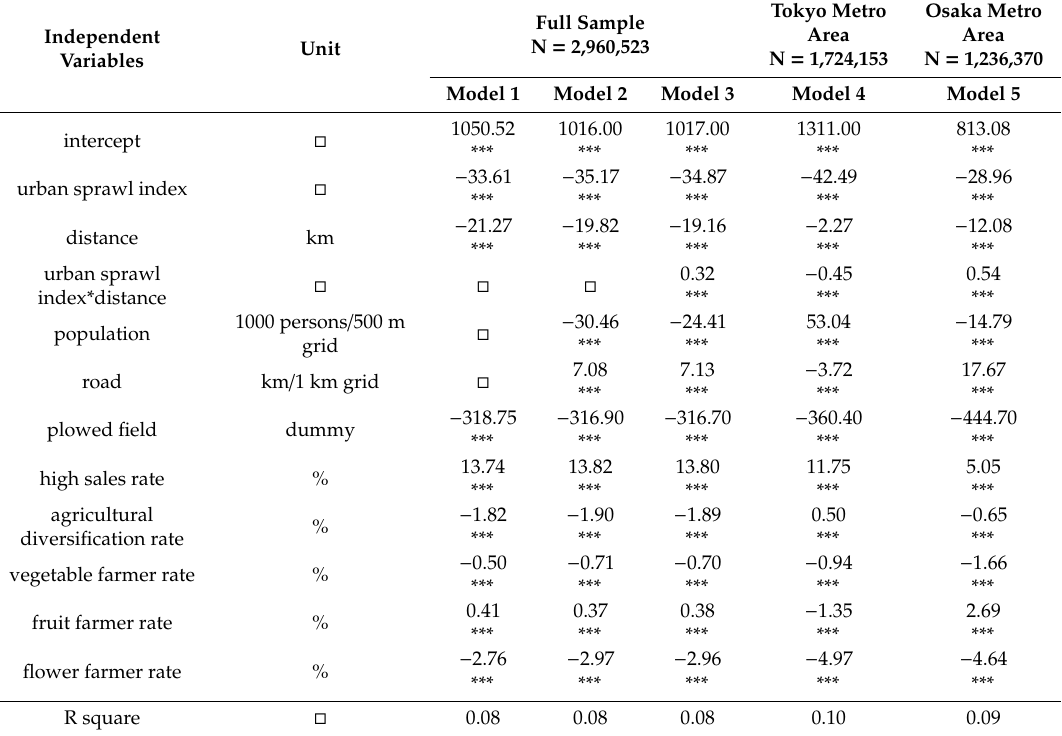
Table 4. E ff ects of urban sprawl and distance from DID on farmland parcels.